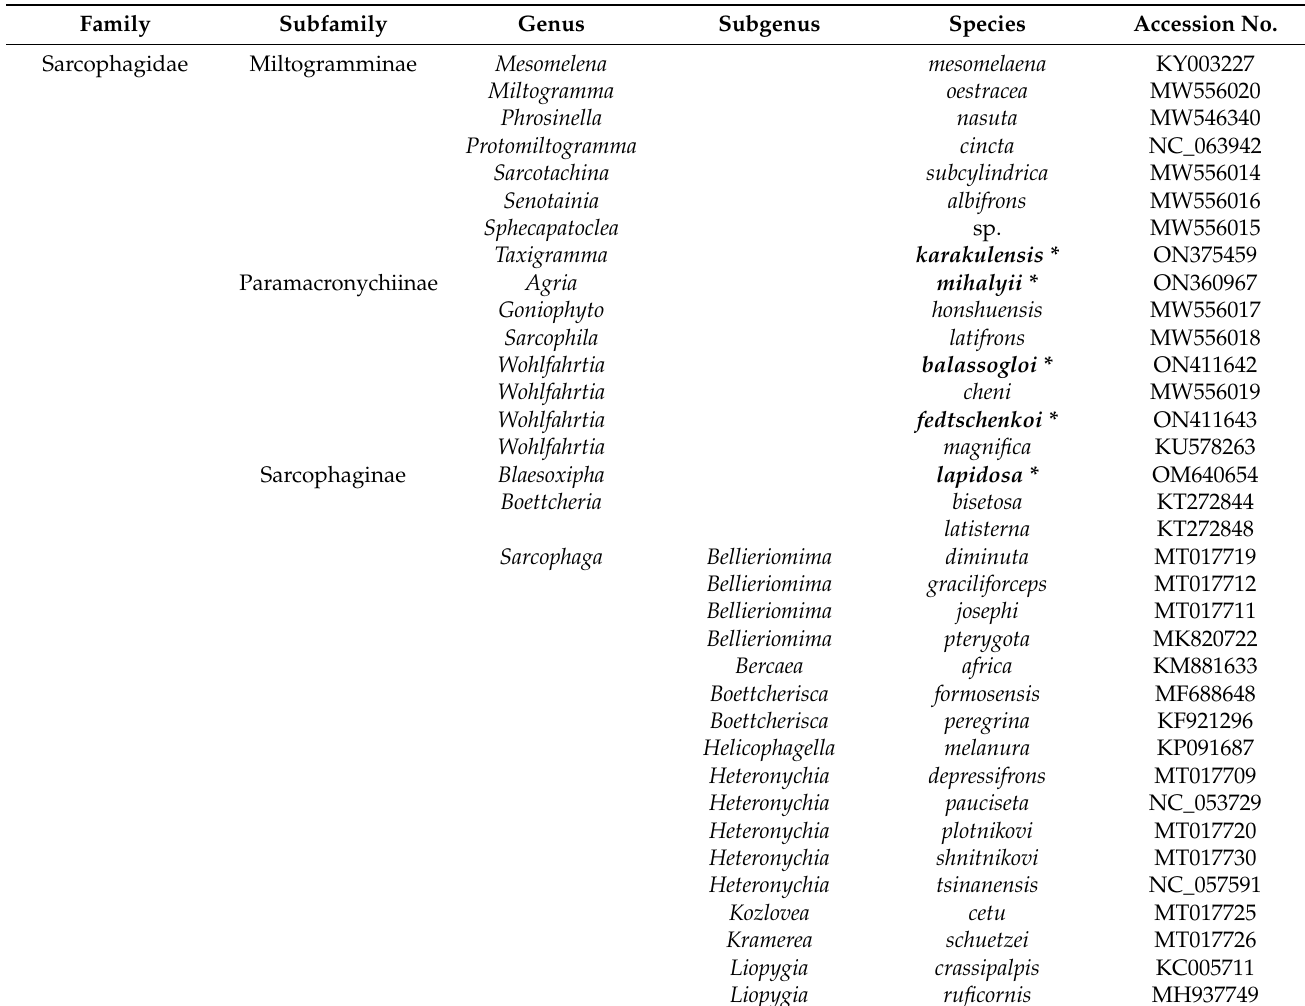
Table 1. Taxonomic information and GenBank accession number of mitochondrial genomes used in the